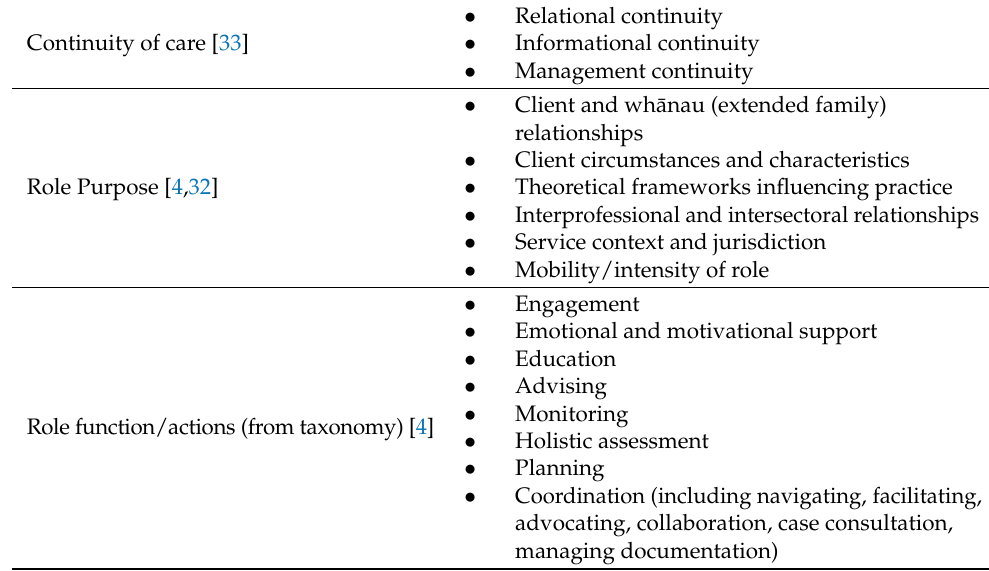
Table 1. Concepts underpinning case management